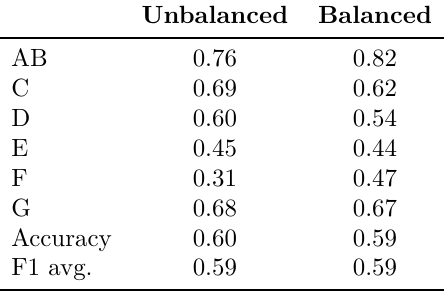
Table 5. Global building efficiency